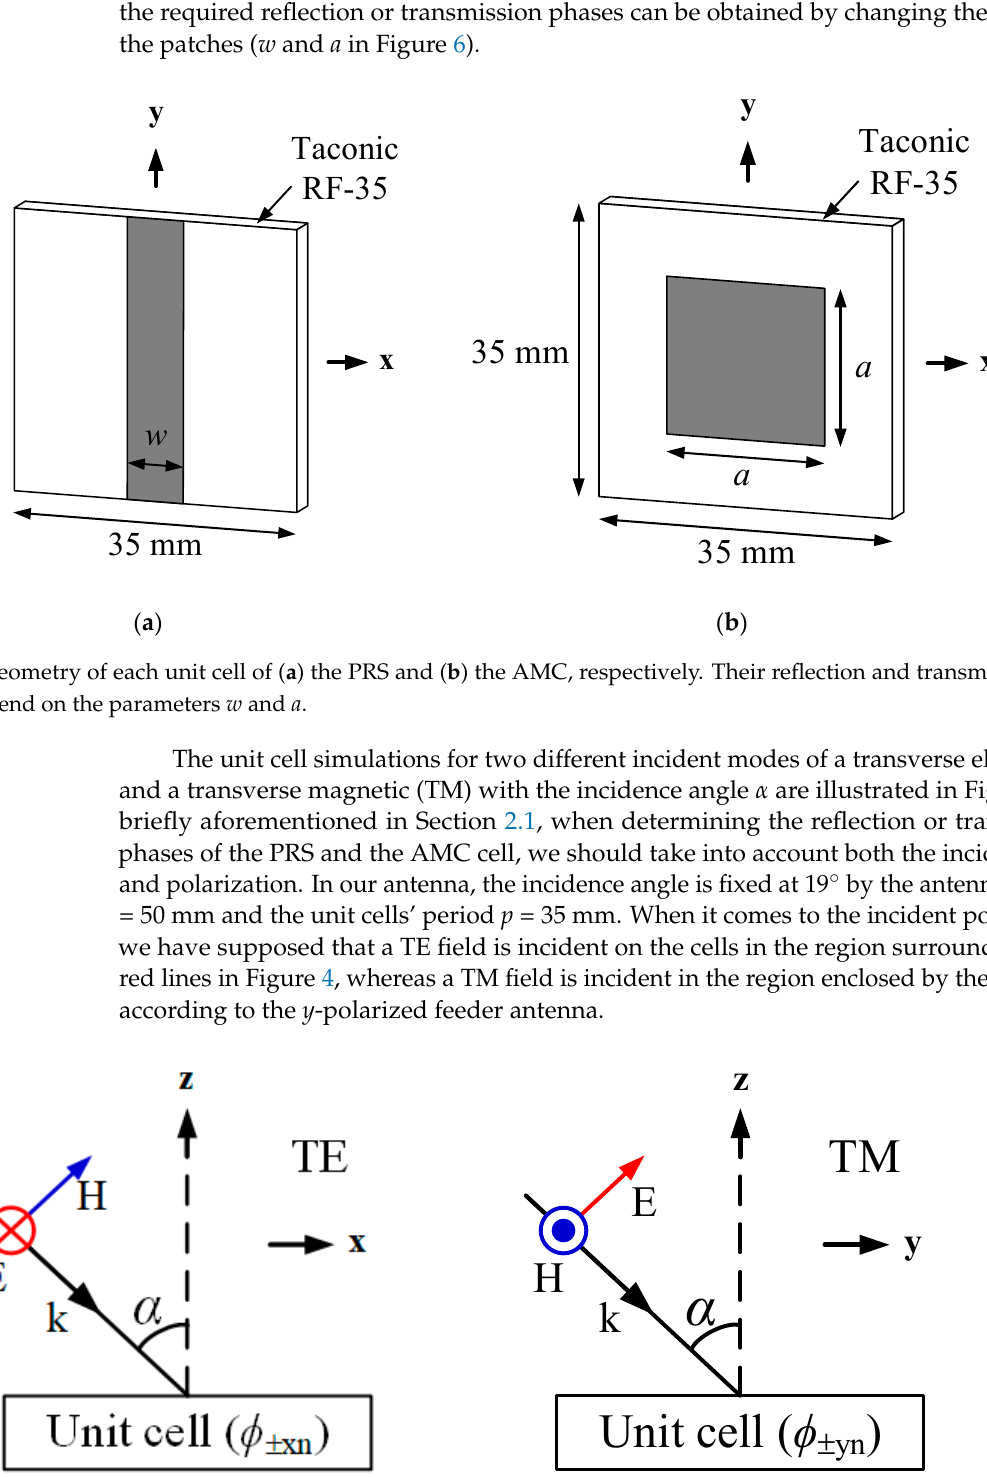
7 of 13 Figure 5. The U-slot microstrip patch antenna used as a source antenna. The design parameters are